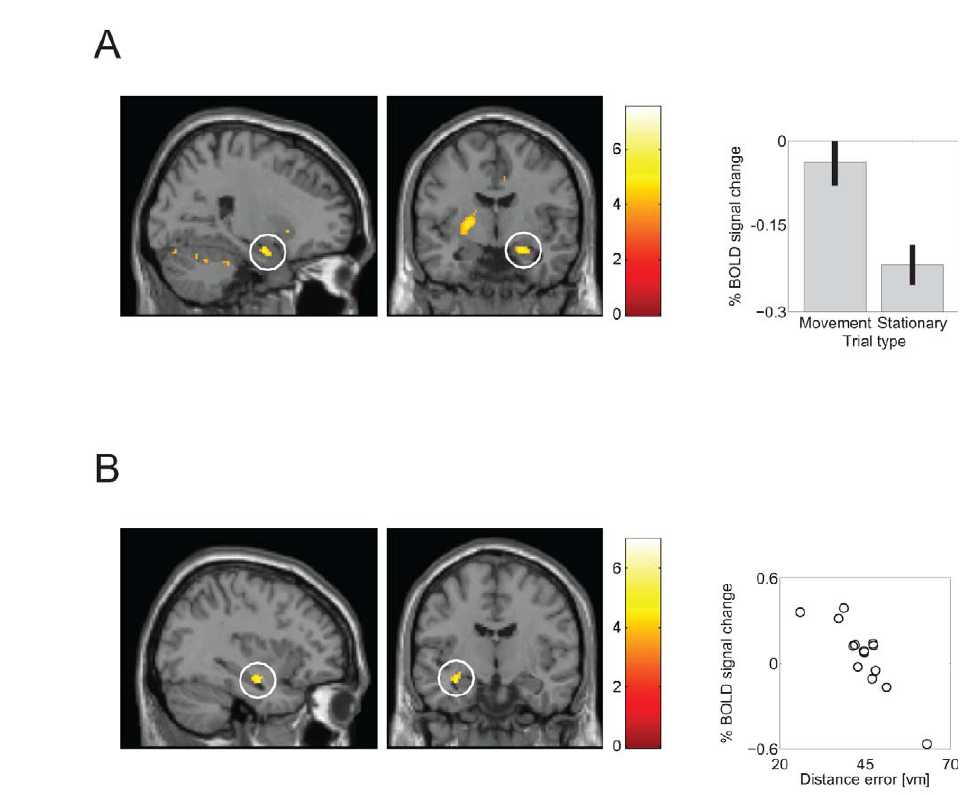
Figure 4. Movement- and performance-related fMRI effects. (A) Left: Sagittal and coronal slices showing right hippocampal activation for movement initiation compared to stationary periods (peak x=24; y= 2 6; z= 2 18; Z-score=3.83, thresholded at p , .001). Right: Percent signal change at right hippocampal peak-voxel averaged across 14 participants for movement and stationary periods (mean 6 SEM). (B) Left: Sagittal and coronal slices showing the correlation of left hippocampal activation during movement initiation with each participant’s mean performance (peak voxel x= 2 32; y= 2 10; z= 2 14; Z-score=3.66; thresholded at p , .001; right-hippocampal activation, not shown, has peak x=40; y= 2 18; z= 2 14; Z- score=3.20). Right: Percent signal change in left hippocampus for each participant plotted against his or her average replacement accuracy in virtual meters. Activations are overlaid on the SPM8 canonical single-participant T1 image.